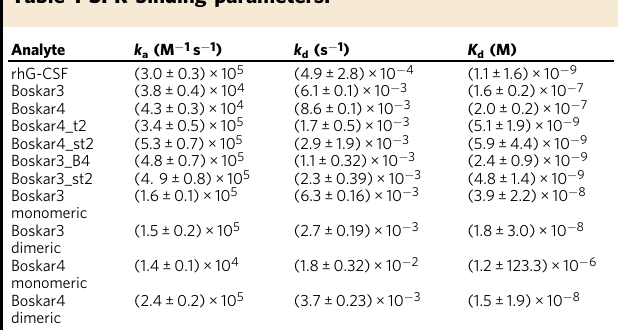
Fig. 5 The designs bind to the human G-CSF receptor. SPR titration sensorgrams of the binding kinetics of A rhG-CSF (Filgrastim), B Boskar3, C Boskar4, and D Boskar4_t2. The binding kinetics analysis (association curve fi ts shown in spectrum colours) indicates higher apparent binding af fi nity of inherently bivalent ligands, whereby rhG-CSF and Boskar4_t2 represent two distinct modes of bivalent binding to the G-CSFR. Table 1 SPR binding